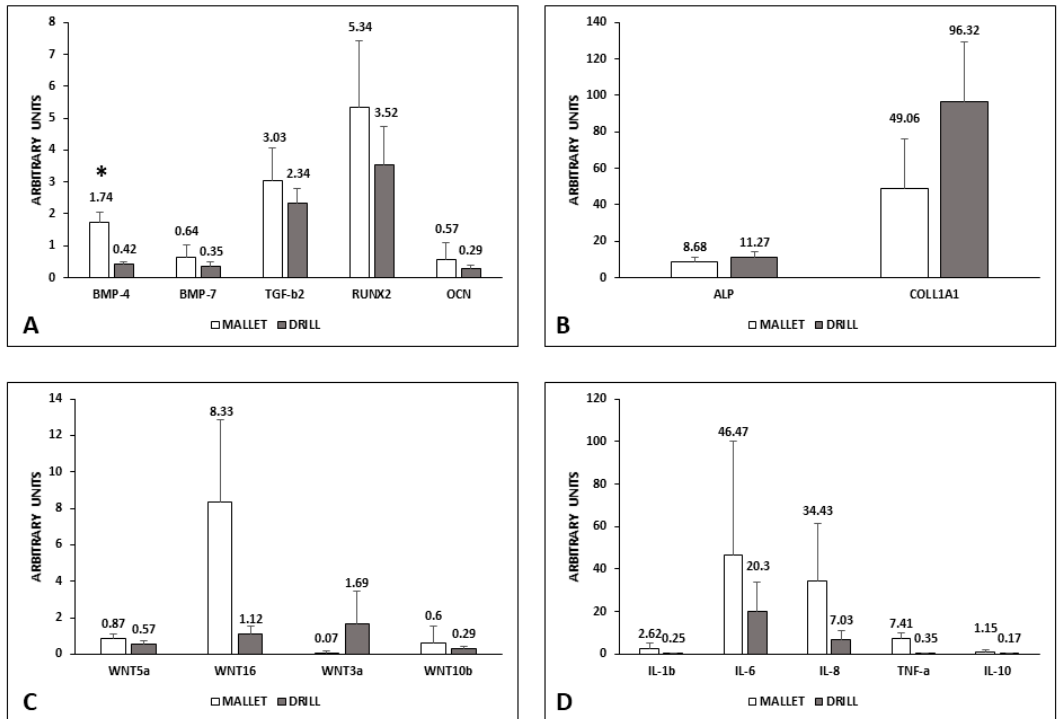
Figure 2. mRNA level of osteogenic and inflammatory factors in peri-implant bone tissues. Panels ( A , B ): osteogenic factors; panel ( C ): WNT pathways; panel ( D ): inflammatory factors. Data represent the mean ± SEM of the evaluations carried out on bone samples obtained at T14. For each animal, the mRNA amounts detected at this time were normalized with respect to the values found in the corresponding bone at T0. Student’s t Test: BMP-4 * p = 0.017. BMP-4, bone morphogenetic protein-4; BMP-7, bone morphogenetic protein-7; TGF- β 2, transforming growth factor- β 2; RUNX2, RUNX family transcription factor 2; OCN, osteocalcin; ALP, alkaline phosphatase; COLL1A1, collagen 1A1; WNT, wingless-related MMTV integration site; IL-1 β , interleukin-1 β ; IL-6, interleukin-6; IL-8, unterleukin-8; TNF- α , tumor necrosis factor- α ; IL- 10, interleukin-10.